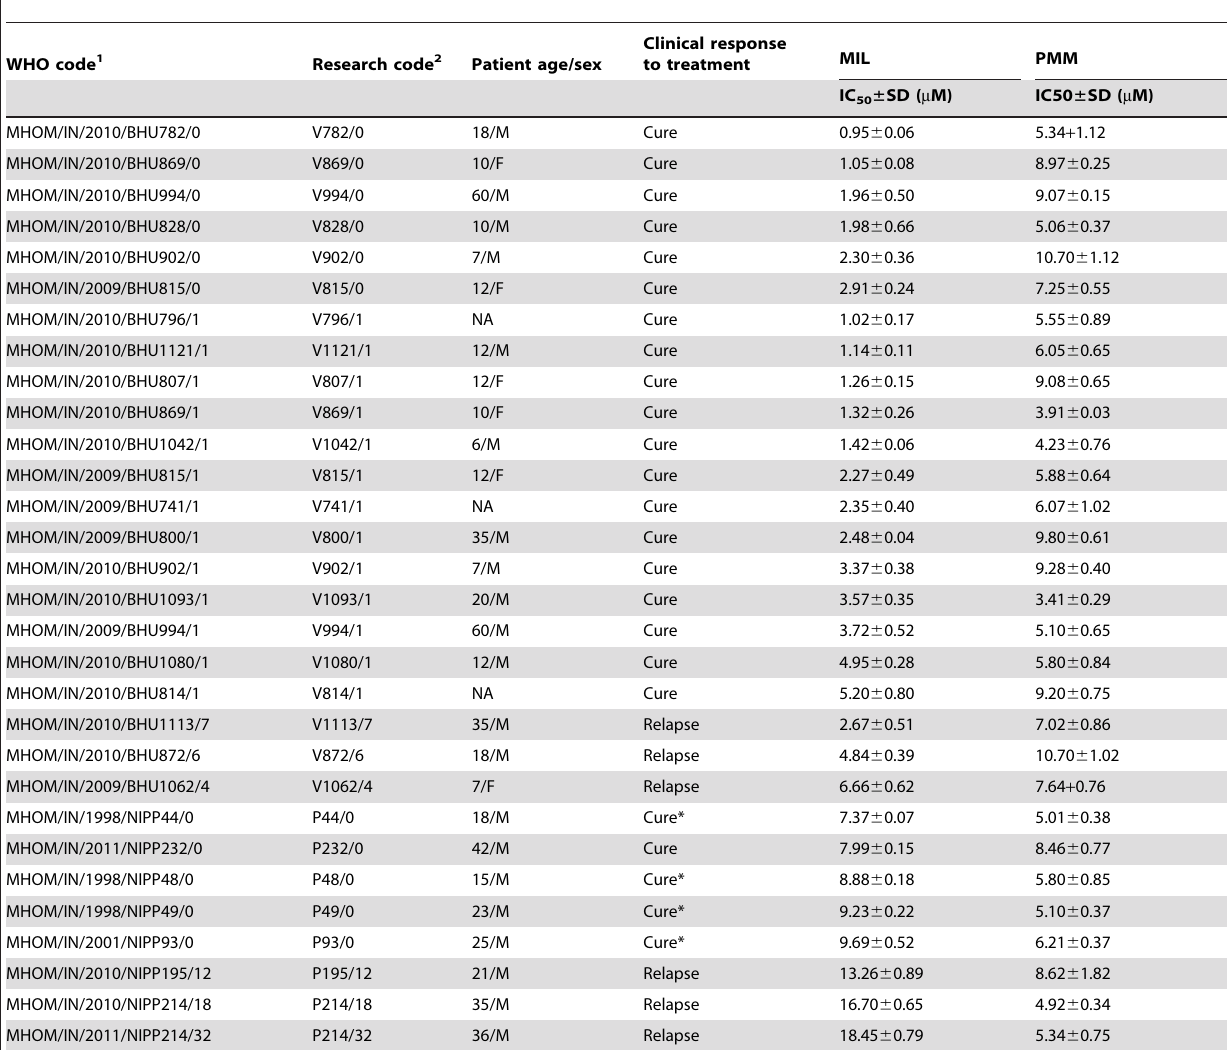
Table 1. Drug susceptibility of Leishmania donovani clinical isolates following Miltefosine treatment in cases of Visceral Leishmaniasis and Post kala-azar dermal